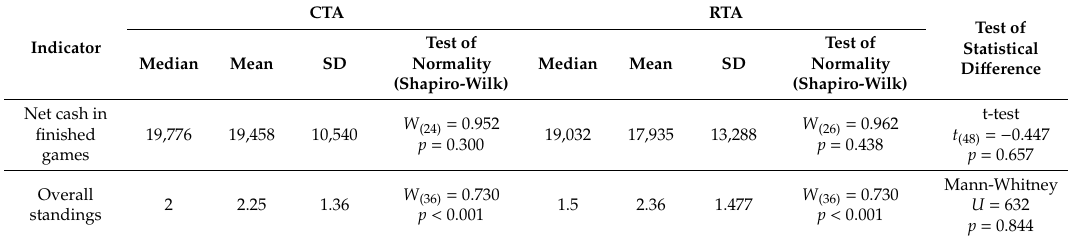
Table 2. Net cash in finished games and overall standings.